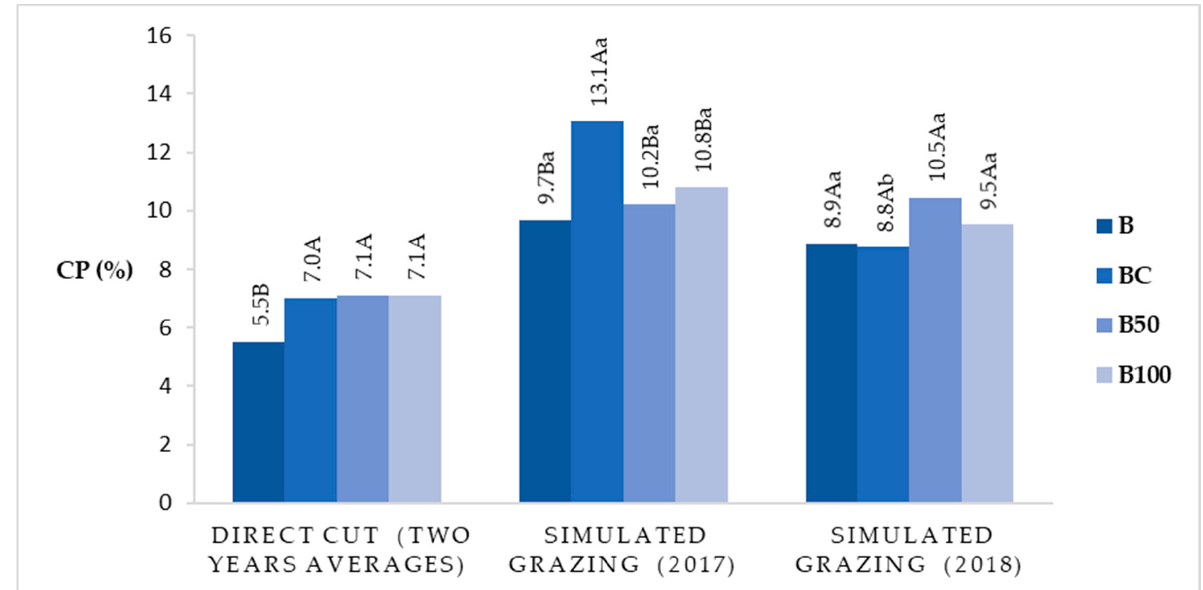
Figure 2. Average values of crude protein (CP) content in signal grass pastures, via direct cutting (among treatments) and via simulated grazing samples (interaction between treatments and years), at the end of the deferral period. Means followed by at least one capital letter (compares treatments) and one lower case (compares years) do not differ at the level of a 5% probability by the Tukey’s test. Abbreviations: B, signal grass which was not fertilized with nitrogen (control); BC, signal grass intercropped with calopo; B50, signal grass fertilized with a dose of 50 kg ha − 1 N; B100, signal grass fertilized with a dose of 100 kg ha − 1 N.